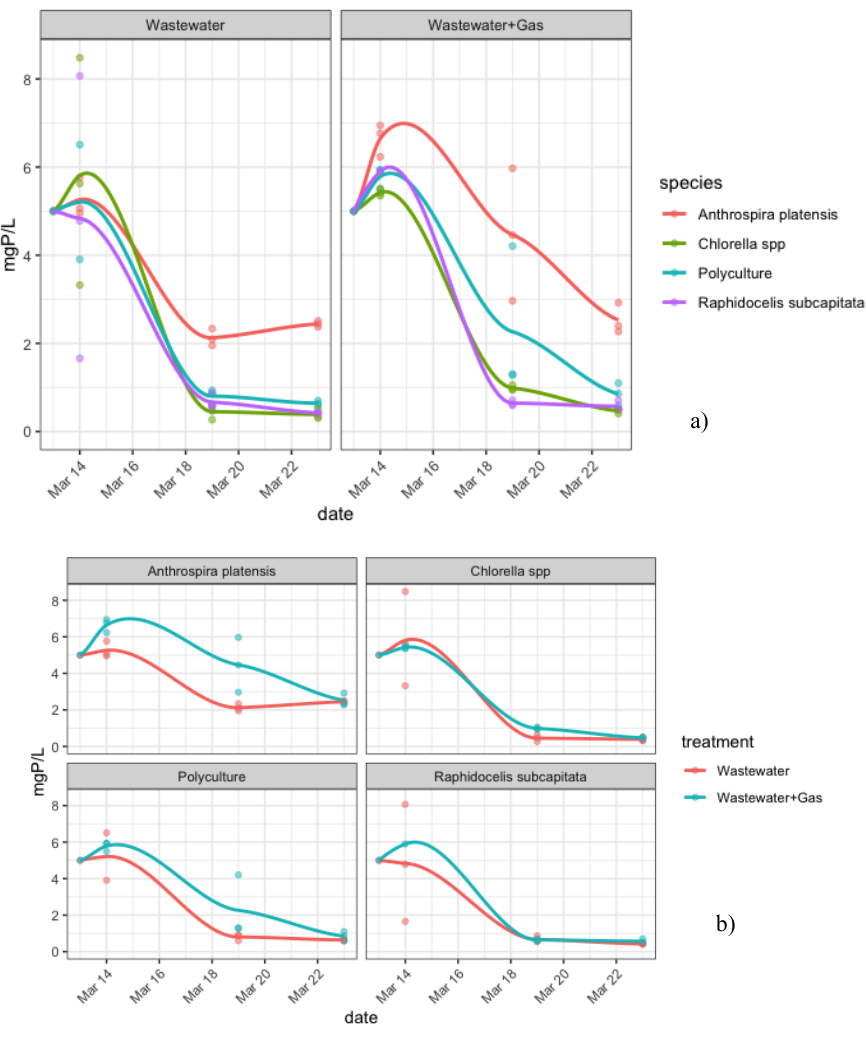
Fig. 3. Phosphorus consumption grouped by: a) treatment, b)